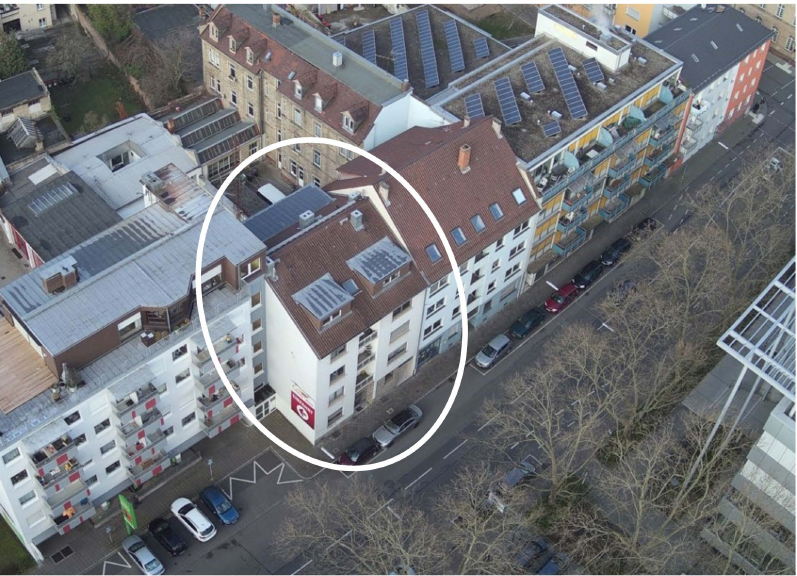
Figure A29. Reference building for an exemplary thermal bridge assessment (north orientation).